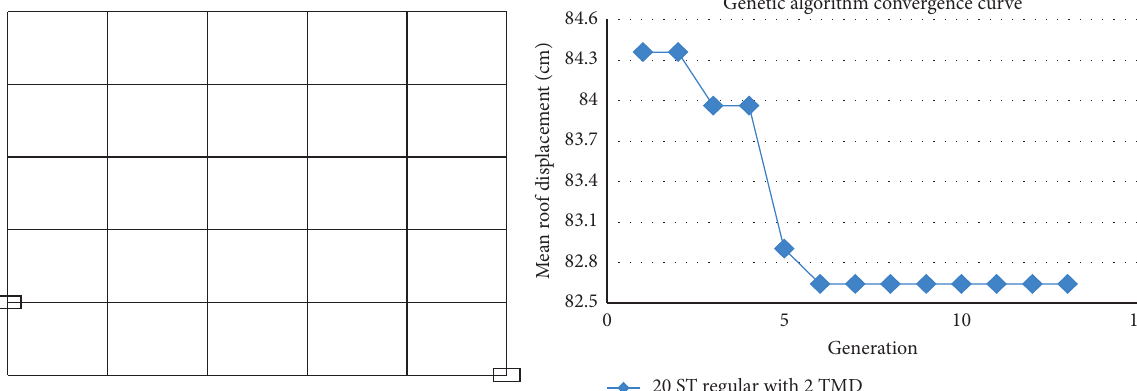
Figure 25: Convergence diagram of the twenty-story model with 2 dampers in genetic algorithm (right) and damper optimal positions (left).